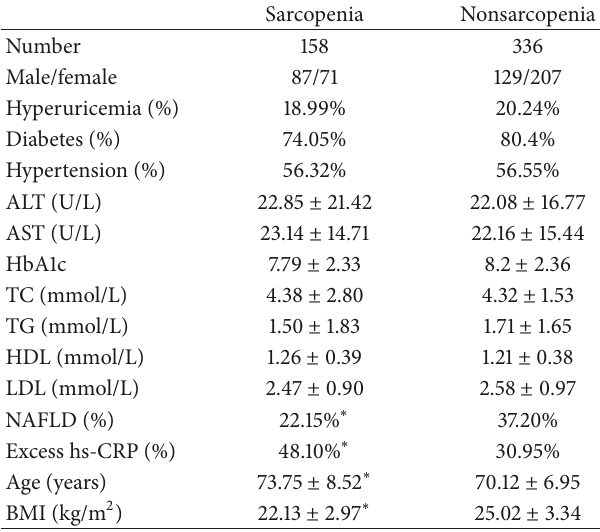
Table 1: Clinical characteristics of the study population.